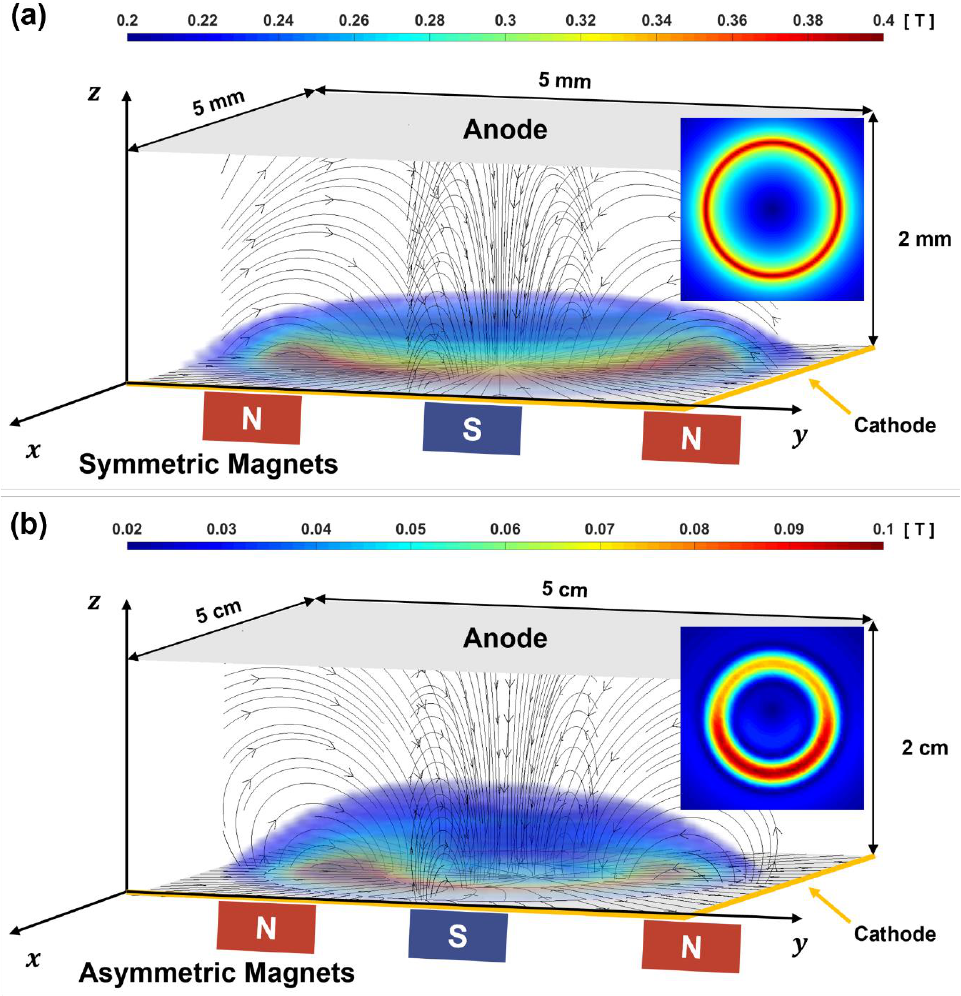
Figure 11. Schematic domains and profiles of magnetic fields in the three-dimensional simulation with ( a ) azimuthally symmetric magnets and ( b ) azimuthally asymmetric magnets. Schematic diagrams of the 3D simulation domain with both azimuthally symmetric The design of permanent magnets can vary depending on either the desired erosion and asymmetric magnetic fields are depicted in Figure 11a,b, respectively. The simu- region of the target plate or the characteristics of deposited thin films. For example, azi- lation domains for both cases indicate simplified DCMS systems with boundaries that muthally asymmetric magnets make magnetic fields, and generated plasmas focus on a consist of one cathode surface and five grounded conductors. A fixed electric current is applied to the cathode in this 3D simulation instead of the constant electric power to obtain simulation results more quickly. Note that the simulation conditions differ since the results are obtained from different studies. For the symmetric case, the domain size is 5 mm × 5 mm × 2 mm, and the number of cells is 80 × 80 × 32. The applied current is 2 mA. The time step ∆ t is 2 × 10 − 11 s. The gas pressure is set to 150 mTorr. Argon gas is used and assumed to be uniform in the discharge region. For the asymmetric case, the domain size is 50 mm × 50 mm × 20 mm, and the number of cells is 64 × 64 × 32. The applied current is 20 mA. The time step ∆ t is 1 × 10 − 11 s. The gas pressure is set at 50 mTorr. It also considers uniform argon feed gas in the discharge region. The data were extracted at r = 1.6 mm and r = 1.6 cm, respectively, to investigate the change in the azimuth direction over time in the symmetric magnet and asymmetric magnet cases. These radii were set to follow the line of the maximum electron density when extracting data in the azimuth direction. The axial positions of the symmetric and asymmetric magnets were set to 0.75 mm and 3.125 mm, respectively, because the steady state results showed that the electron densities here had peak points on the two-dimensional xy